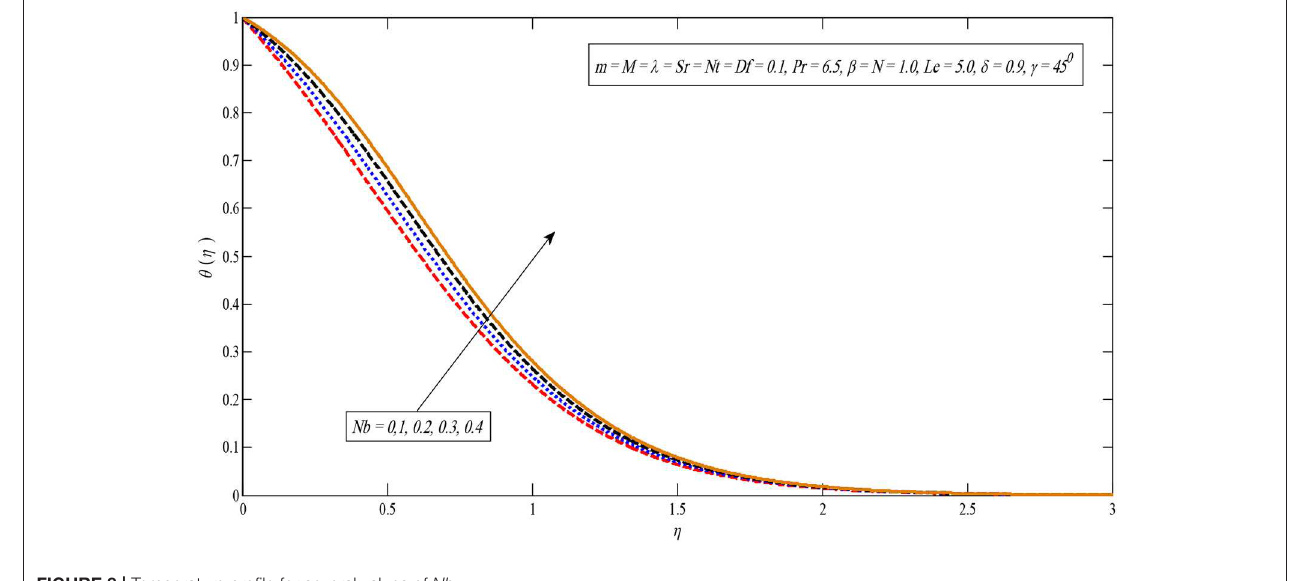
FIGURE 8 | Temperature profile for several values of Nb .